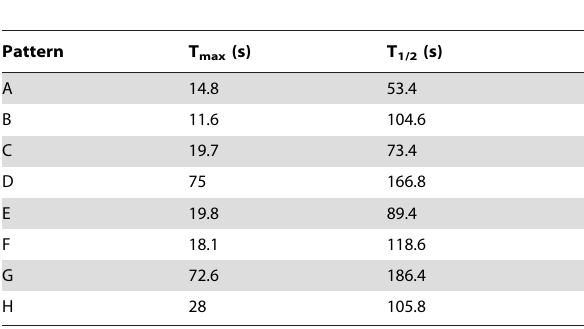
Table 2. T max and T 1/2 values in time-intensity curves for perfusion of the entire uterine region with different patterns of blood